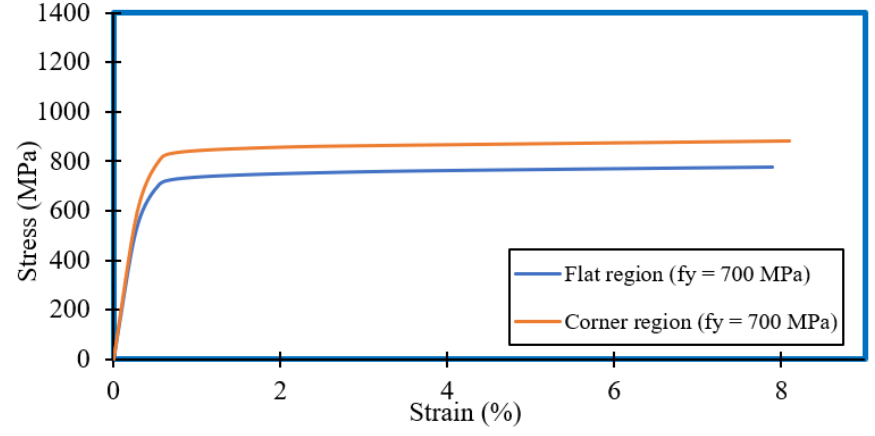
Figure 5. Stress–strain curve for flat and corner regions ( f y = 700 MPa).